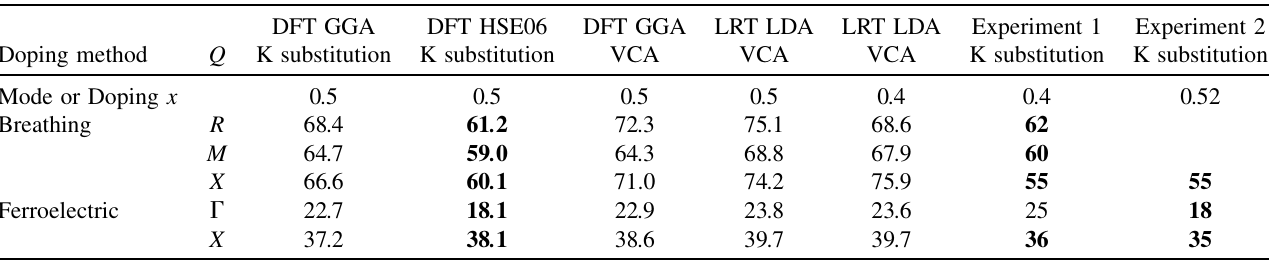
TABLE I. Phonon frequencies of the important longitudinal optical phonon modes at high symmetry points in BaKBi by supercell frozen-phonon calculations in the DFT GGA and DFT HSE06 framework. For comparison, the corresponding phonon frequencies from the LRT LDA calculations for Ba measurements (experiment 1 from Ref. [69] and experiment 2 from Ref. [33]), are also displayed.